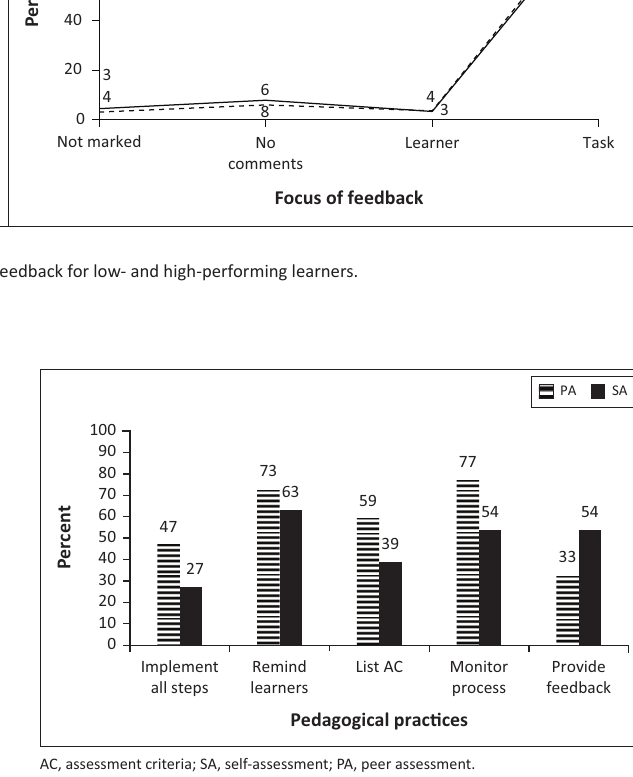
FIGURE 8: Teachers’ use of peer ( n = 22) and self-assessment ( n = 38) during